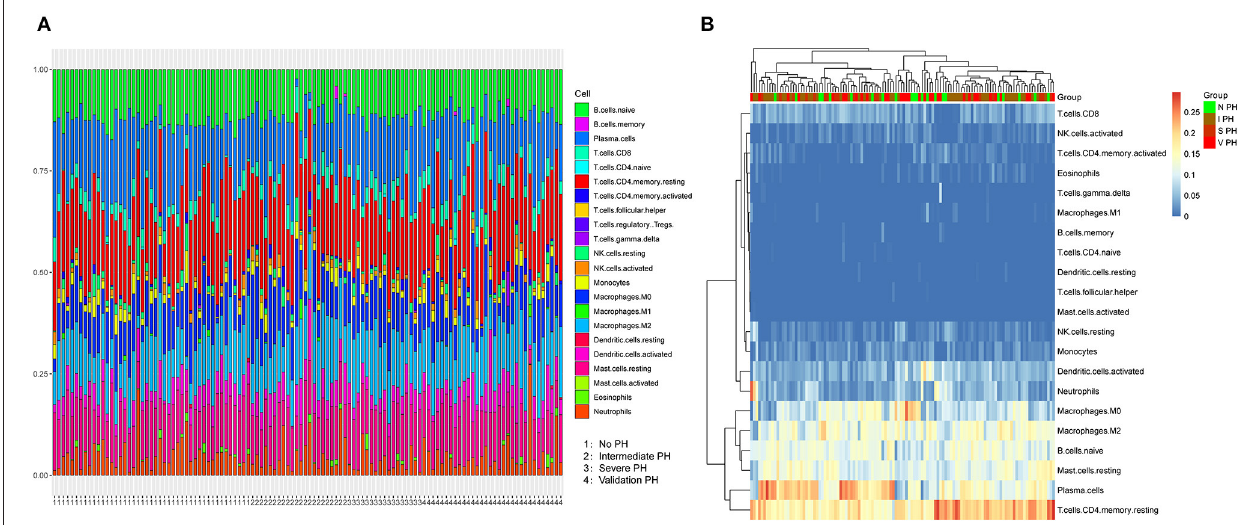
FIGURE 1 | Characterization of immune cell infiltration subsets in PF patients associated with PH. (A) The proportions of 21 immune cells varied in samples with PH or non-PH. Horizontal axis represented the patients with non-PH, intermediate PH, severe PH and validated PH. (B) Hierarchic clustering analysis was conducted